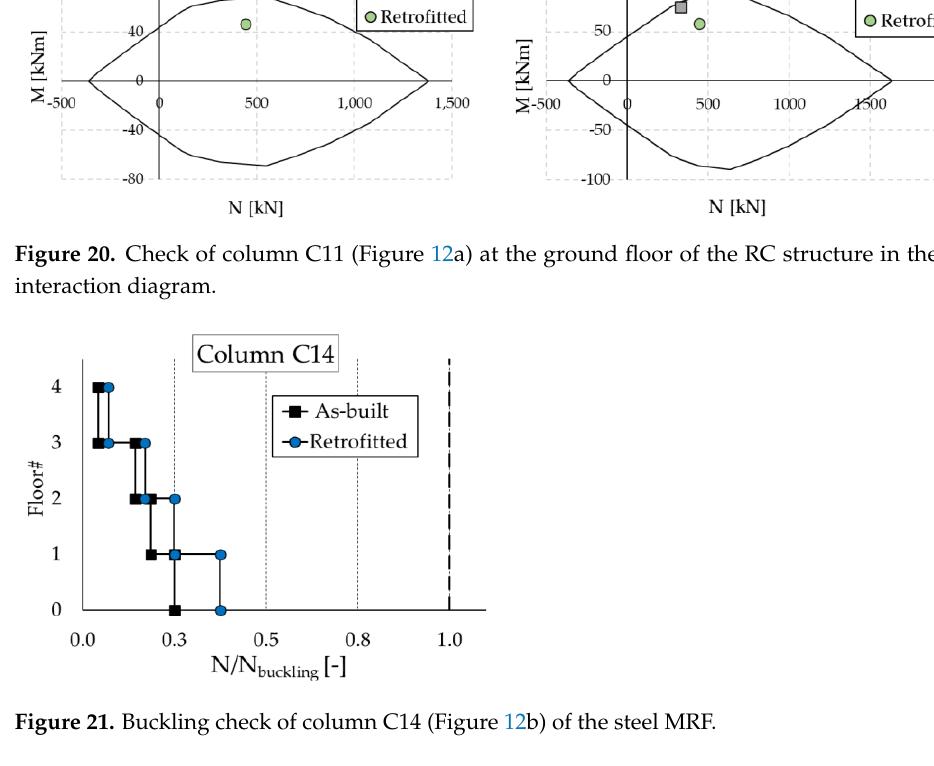
Figure 21. Buckling check of column C14 (Figure 12b) of the steel MRF.